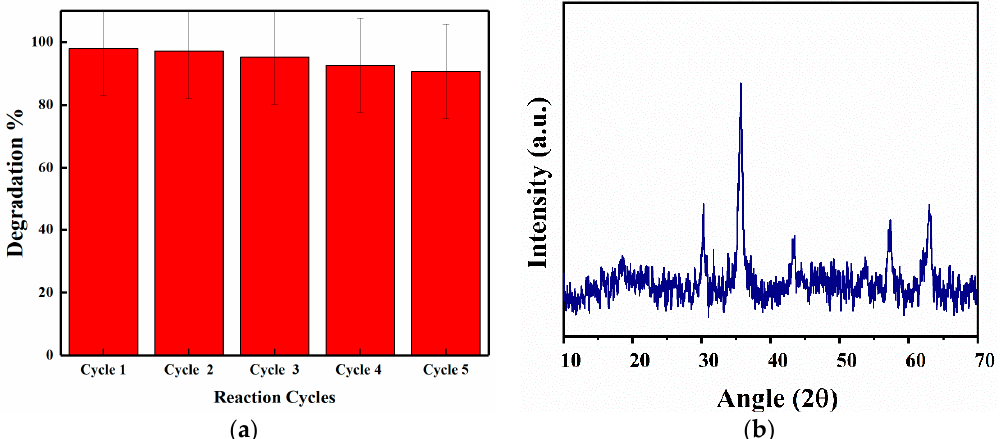
Figure 10. ( a ) Recyclability of SCN/CoFe 2 O 4 nanocomposite; ( b ) FT-IR of recovered SCN/CoFe 2 O 4 nanocomposite after the third cycle.